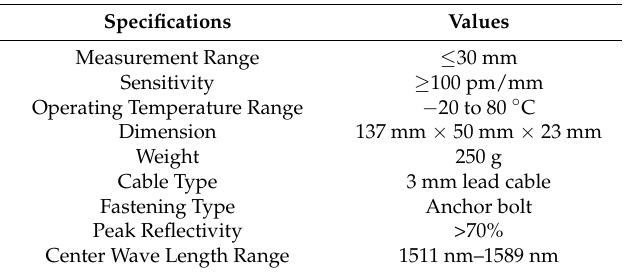
Table 2. Specifications of the FBG displacement gauge.